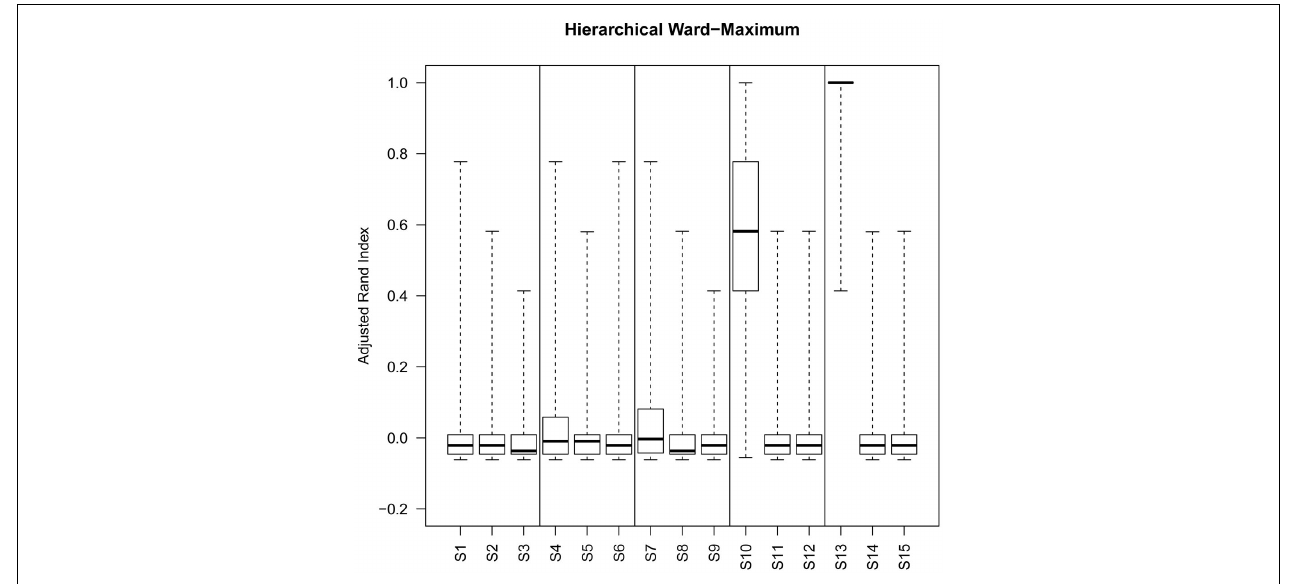
FIGUREA1 | Box plots of rand index scores across all simulations. For each figure the solid horizontal line represents the median rand index, the box contains the interquartile range and the whiskers mark the minimum and maximum values.